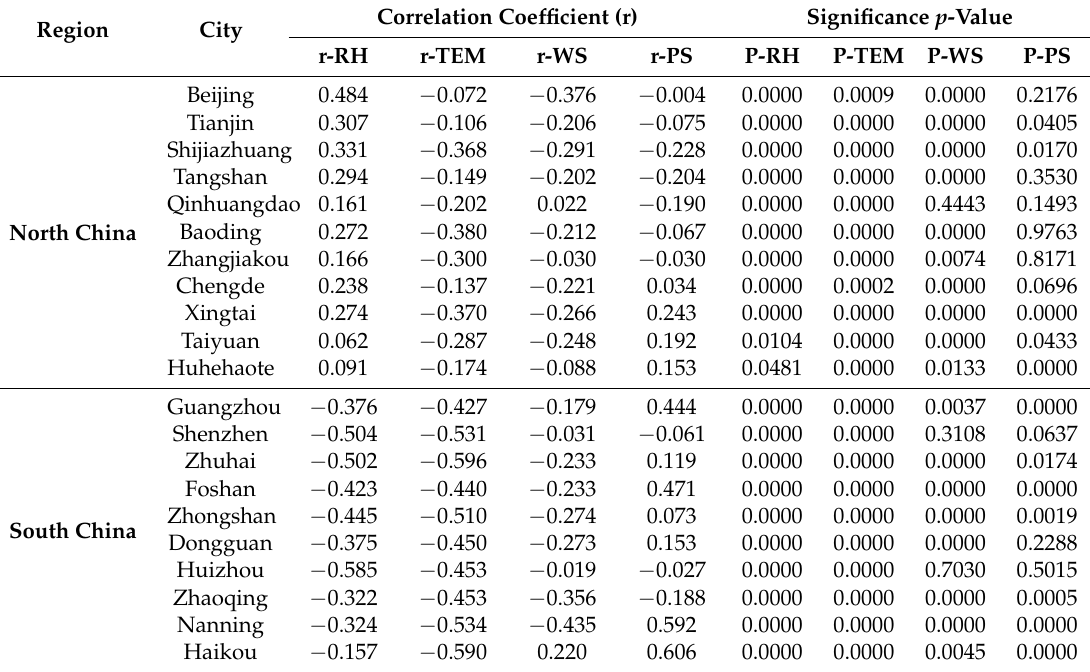
Table 1. The correlation coefficients and p -values of cities in south China and north China. Correlation Coefficient Region City